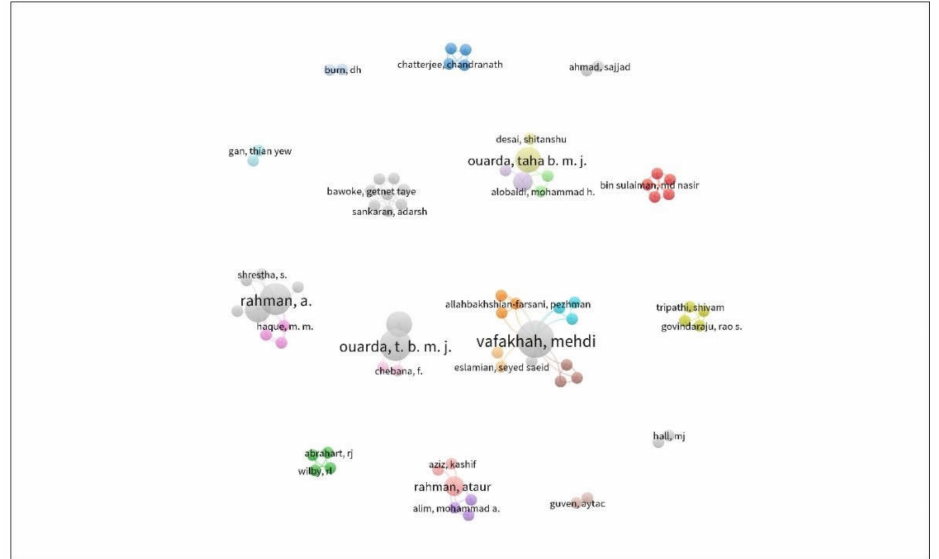
Figure 6. Map showing clusters of authors.